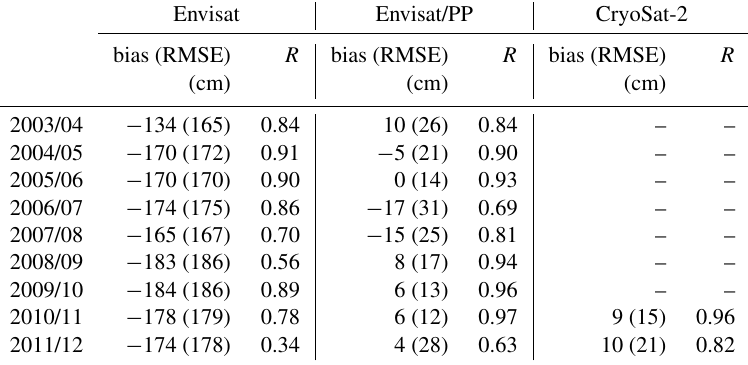
Table 2. Average winter bias, root mean square error (RMSE) and correlation coefficient ( R ) between the altimetric and BGEP ice draught estimated during winters 2003/04 to 2011/12 for Envisat and during winters 2010/11 and 2011/12 for CryoSat-2. Envisat